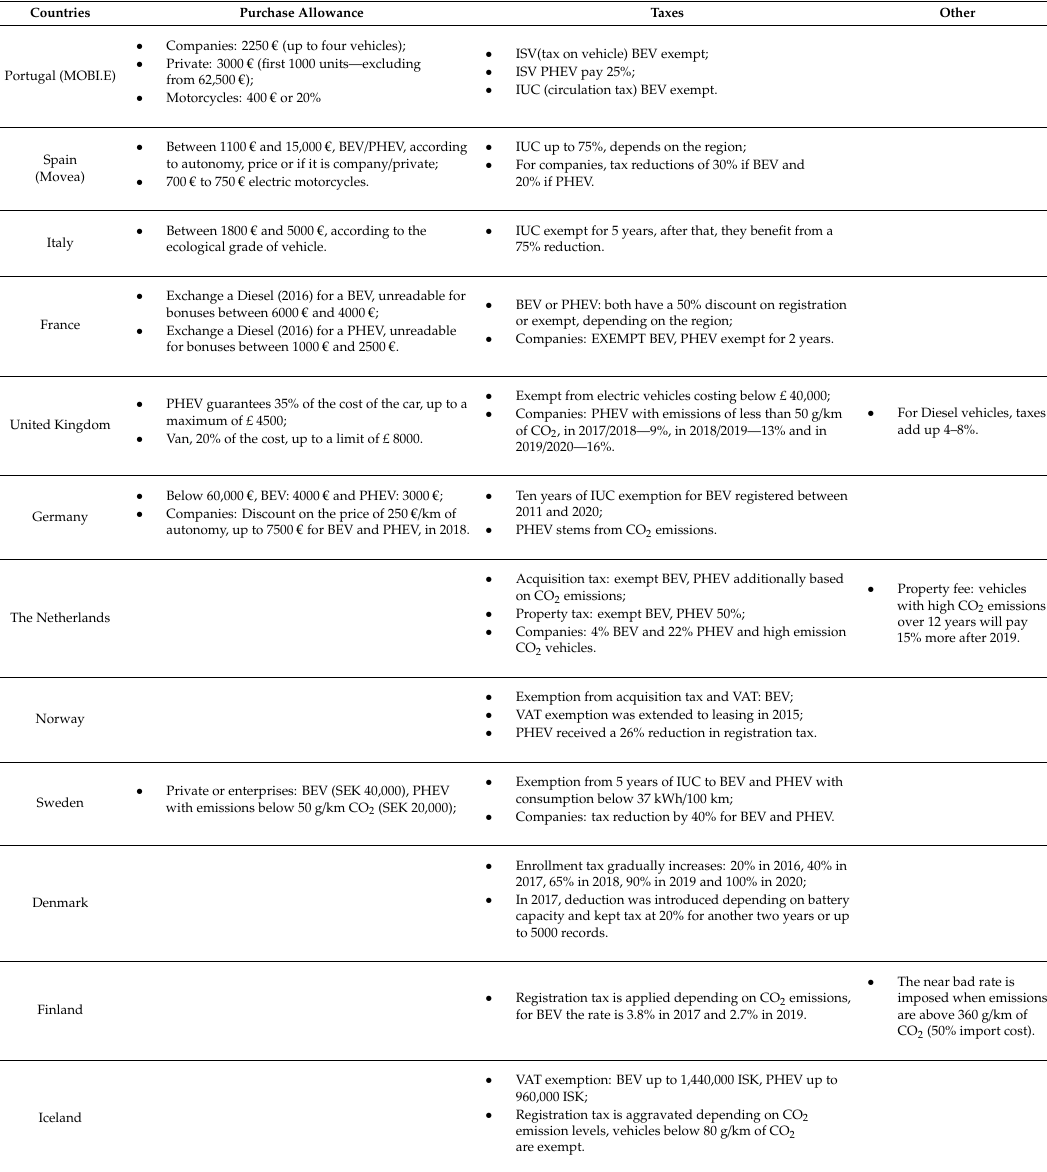
Table 1. Comparison between European Governments incentives and tax